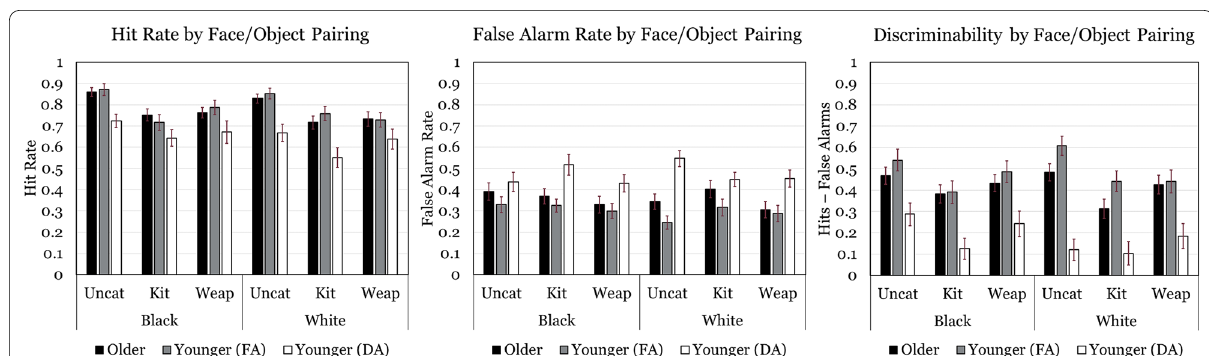
Fig. 5 Hit rate, false alarm rate, and average discriminability for each associative memory combination in each age/attention group. FA Attention, DA Divided =